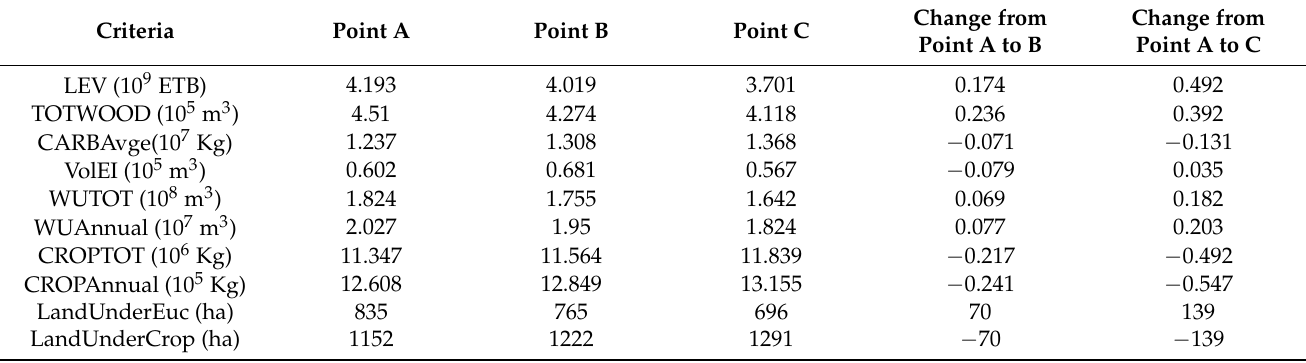
Table 5. Solutions in the feasible set for the selected points (points selected in Figure